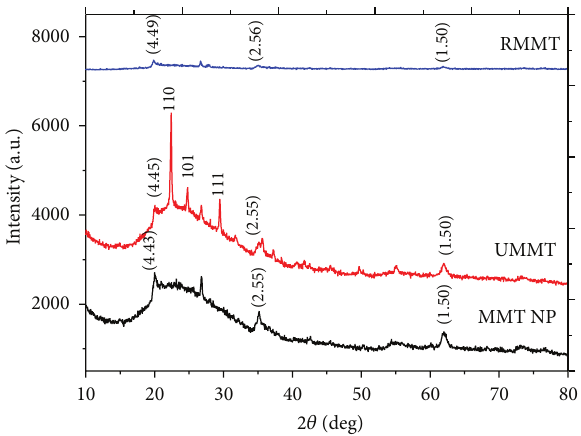
Figure 6: WAXRD patterns of MMT NP, UMMT, and RMMT.